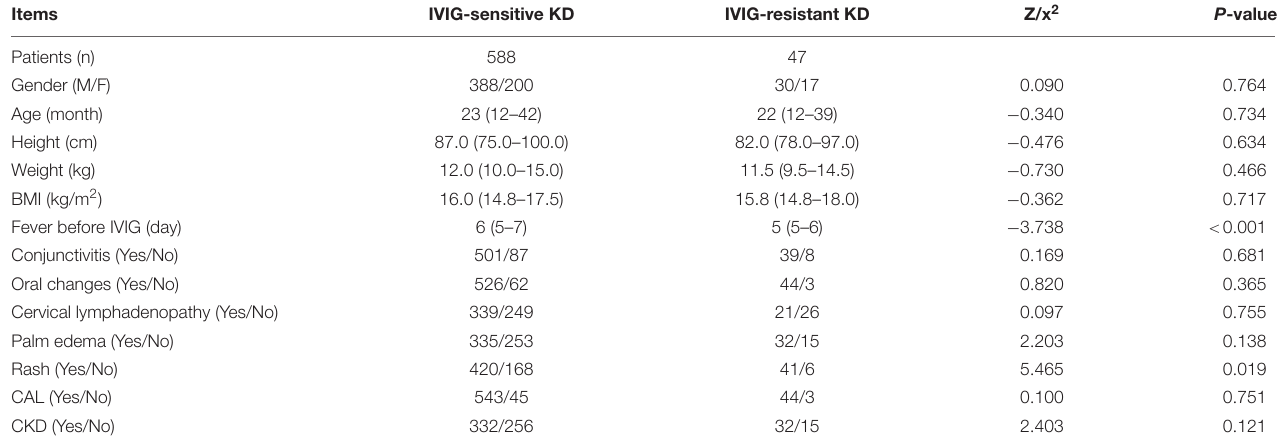
TABLE 1 | Demographic features and clinical manifestations between IVIG-sensitive and IVIG-resistant KD children in the training set. Items IVIG-sensitive